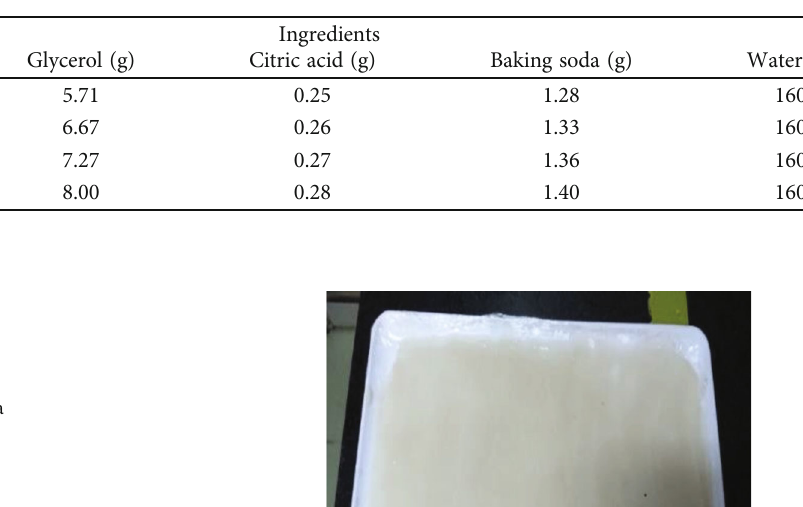
Table 2: The speci fi c weight of each material.